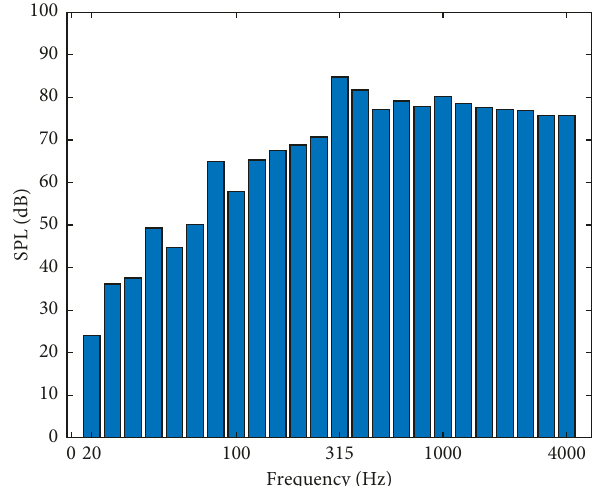
Figure 7: 1/3 octave spectrum of parotic noise sound under the working condition of 2400rpm.